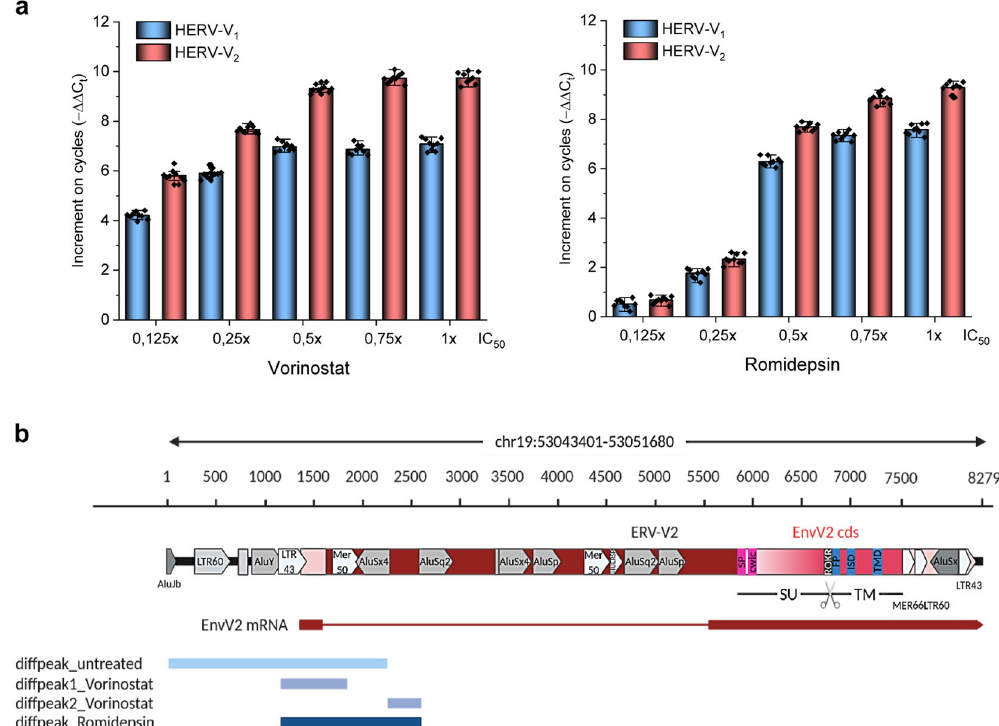
Fig. 5 ChIP-seq analysis after HDACi treatment in SKOV3 WT . a Dose-dependent activation of the HERV-V1/V2 genes in SKOV3 WT cells exposed to different IC 50 fractions of HDACi for 24 h. b The HERV-V2 locus (chr19:53044740 – 53051680) is highlighted by a maroon arrow, along with the mRNA encoding for the EnvV2 protein. Putative LTR sequences are highlighted in peach colour. The EnvV2 coding sequence (cds) is also shown, with the annotations for surface (SU) and transmembrane (TM) subunits: hydrophobic signal peptide (SP), CWIC motif involved in SU and TM interaction (consensus: CXXC), RKQR furin cleavage site separating SU and TM portions (consensus: RXKR), fusion peptide (FP), putative immunosuppressive domain (ISD), and transmembrane domain (TMD). LTR and non-LTR retrotransposon secondary integrations are highlighted by white and grey arrows, respectively. The positions of co-localised diffpeaks before and after HDACi treatment are shown. Promoter (1145-1434) and proximal enhancer (1588- 1751 and 2265-2490) like sequences referring to the whole chromosome region shown as predicted by ENCODE registry of candidate cis-regulatory elements.